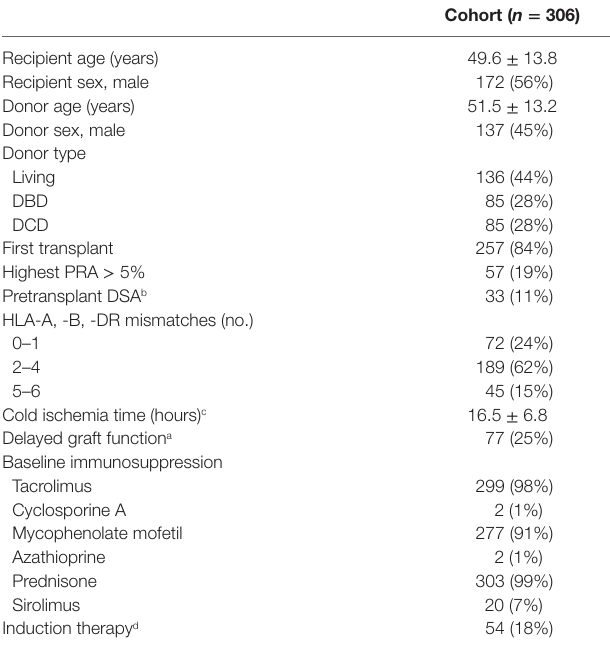
TaBle 2 | Baseline